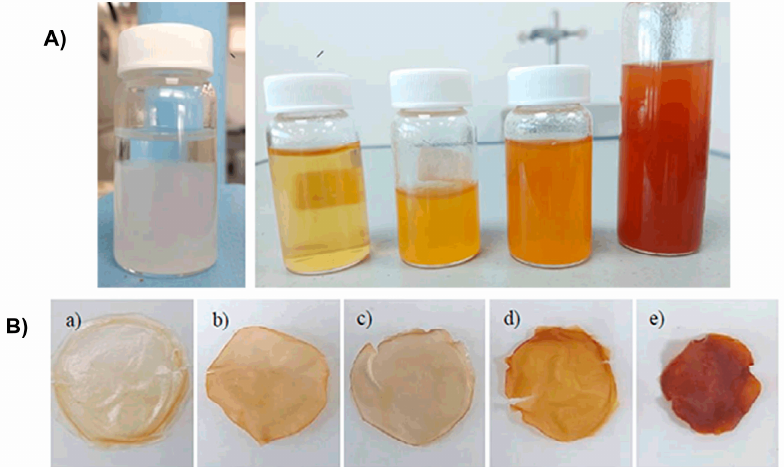
Figure 1. ( A ) Nanocellulose solutions at different concentrations. ( B ) CNF ‐ Fe films with ( a ) 1% w / w Fe, ( b ) 2.5% w / w Fe, ( c ) 5% w / w Fe, ( d ) 7.5% w / w Fe, (e d ) 10% w / w